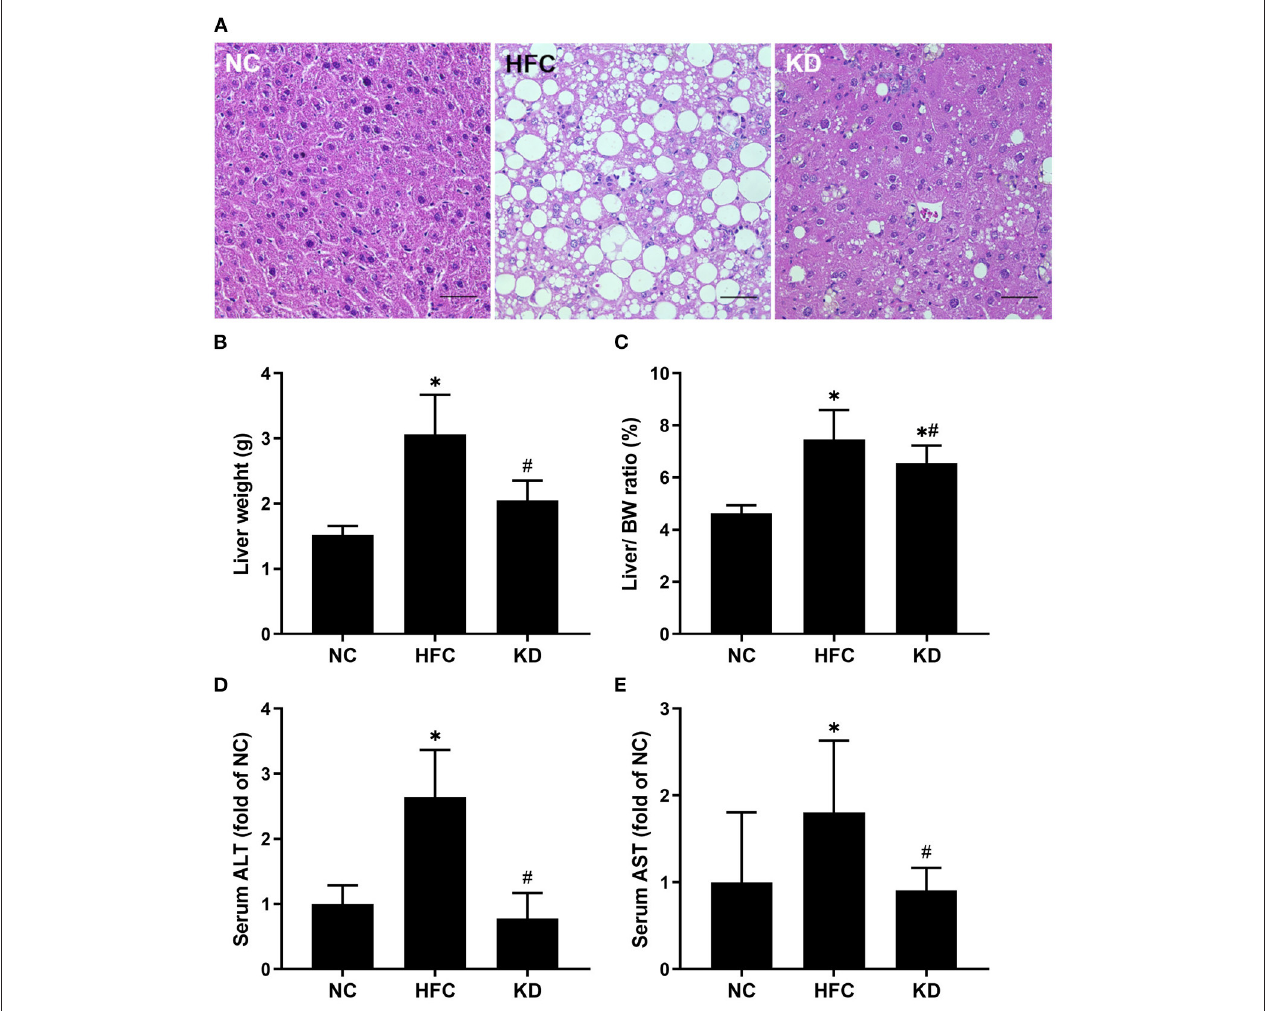
FIGURE 2 | Effects of a high-fat and high-cholesterol diet and a ketogenic diet on (A) hepatic histology, (B) liver weight, (C) liver to body weight ratio, (D) serum ALT level, and (E) serum AST level in male mice. Hepatic sections were stained with hematoxylin and eosin. Data are expressed as the mean ± SD. * p < 0.05, compared with the NC group; # p < 0.05, compared with the HFC group. NC, normal diet; HFC, high-fat and high-cholesterol diet; KD, HFC diet changed to MCT-based ketogenic diet. Scale bar: 50 µ